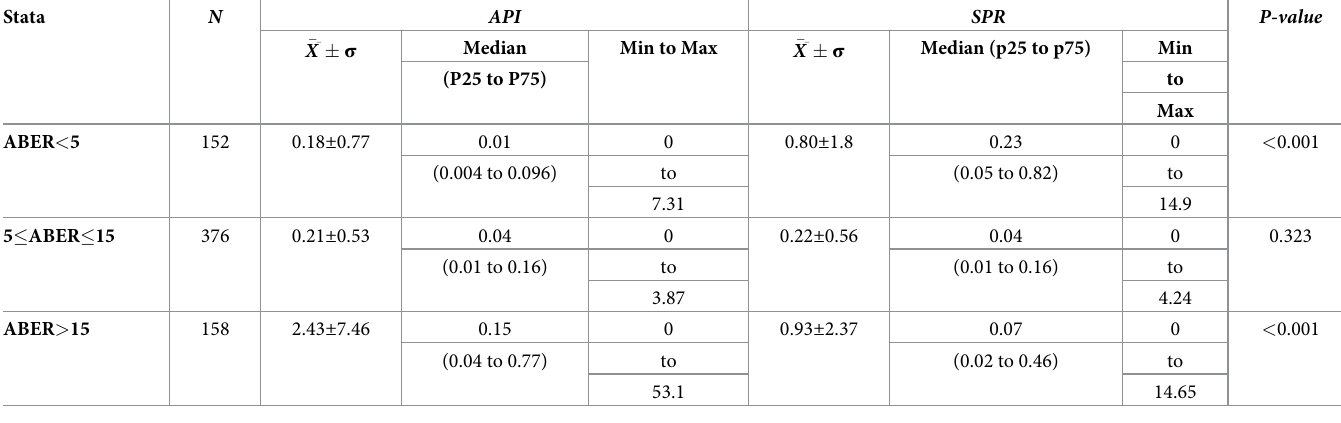
Table 1. Comparison of district API and SPR in three strata of